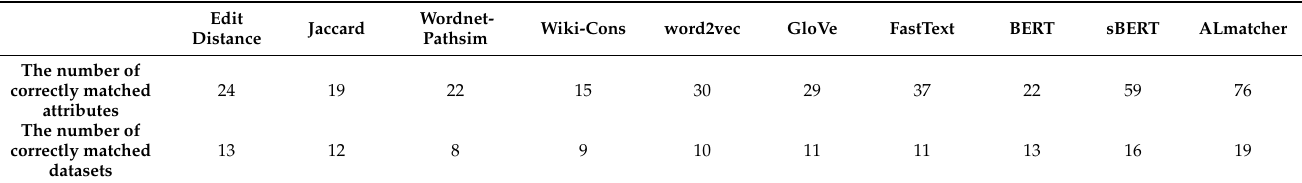
Table 9. Result of the overall schema